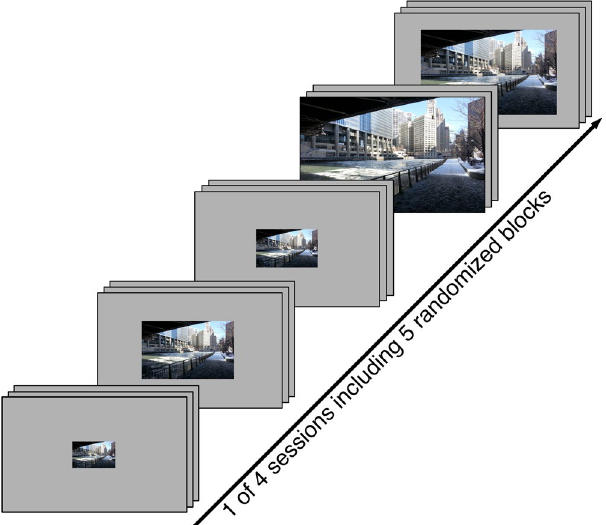
Figure 2. Structure of one of four experimental sessions with randomized order of blocks. Within each block, 18 images (6 images per category) of the same size were presented for 6 s